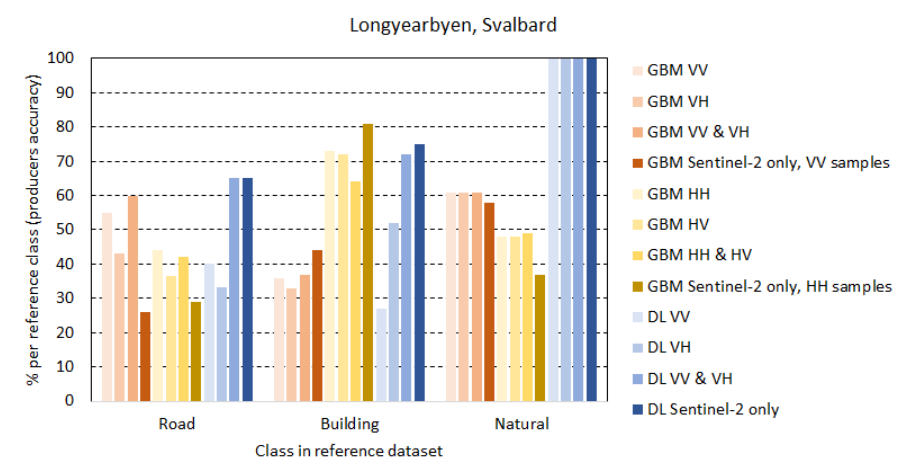
Figure 6. Classification performance results for Longyearbyen, Svalbard (validation data source [54]). DL—Deep Learning, GBM—Gradient Boosting Machines, V—vertical polarization, H—horizontal polarization.